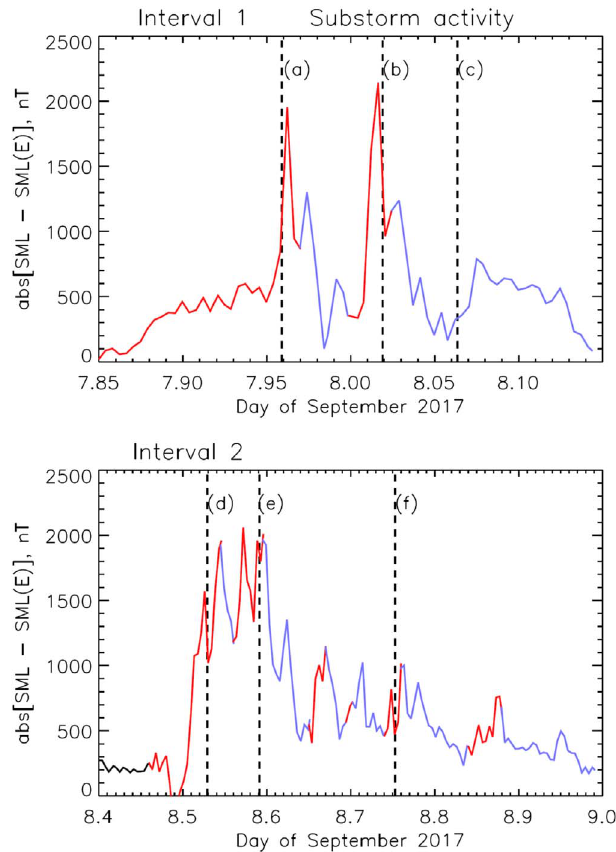
Fig. 9. The SML index with solar wind component removed (cid:1) (SML (cid:1) SML( )) to highlight potential substorm conditions during Interval 1 and Interval 2, on 7 – 8 September 2017. Substorm phases are identi fi ed using the gradient of a 30-min sliding box-car window, which is colour-coded by red intervals to indicate expansion phases, and blue intervals to indicate recovery phases. The times of large d H /d t events, (a) – (f), are